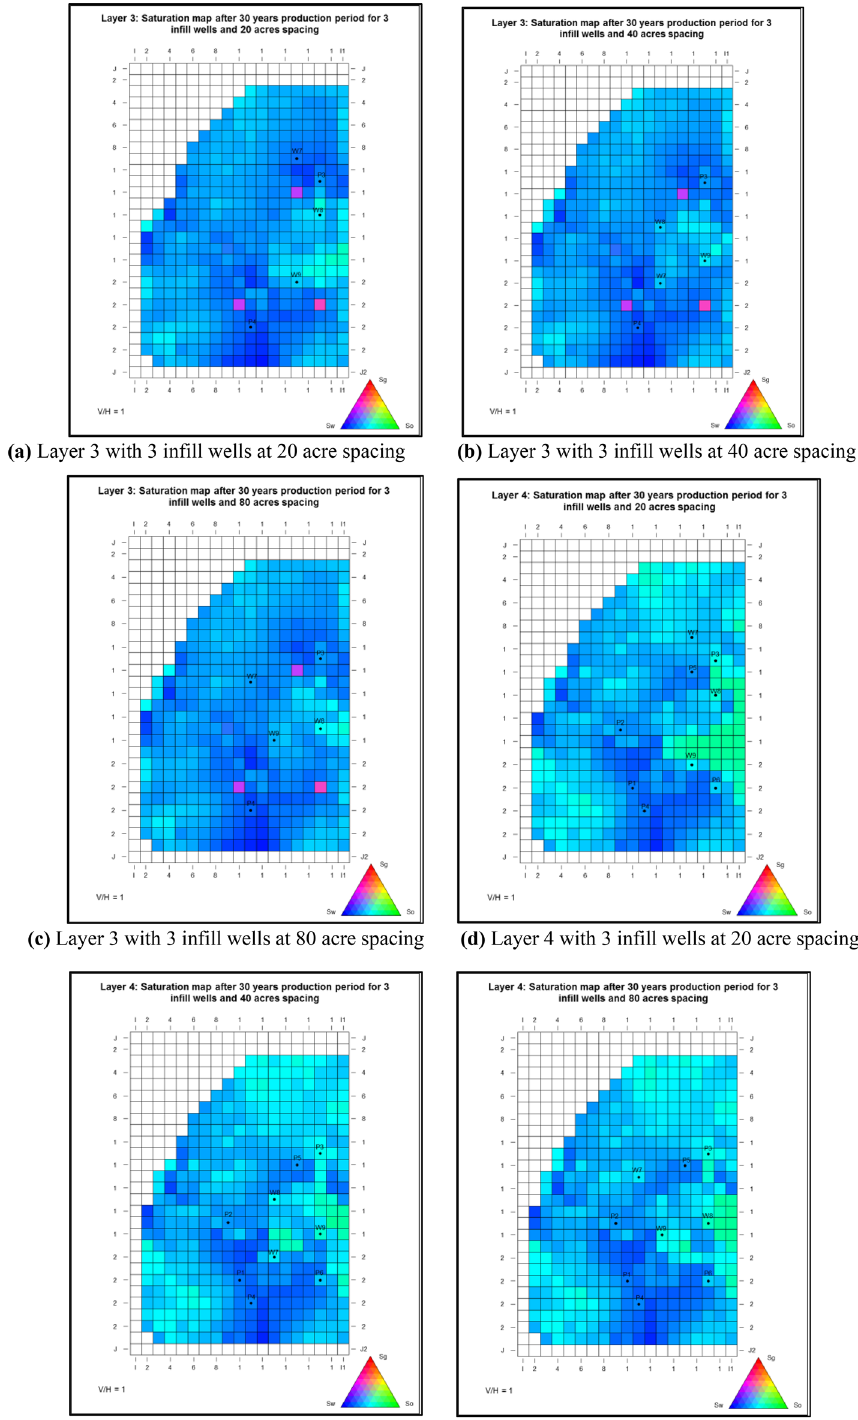
Fig. 10 Saturation distribution maps for layers of the reservoir with 3 infill wells located at dif- ferent well spacings (additional 15 years simulated production